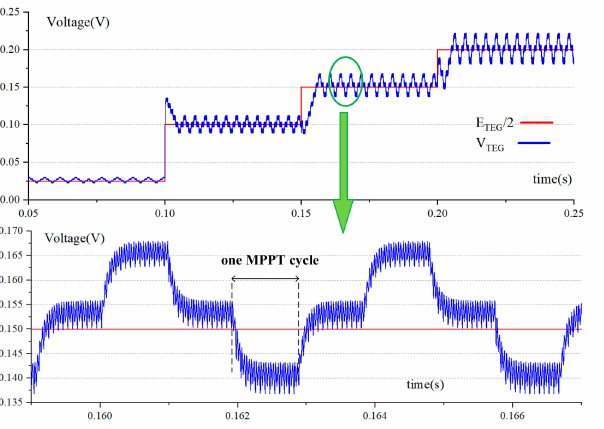
Figure 11. The waveform of V TEG , when E TEG changes from 50 mV to 400 mV and R TEG is 6 Ω . The input power of the DC–DC converter was obtained by the calculator module embedded in Spectre. The input power was divided by the ideal maximum power output of the TEG to obtain the tracking efficiency of the proposed MPPT circuit. The simulation result of the tracking efficiencies was between 98.9% and 99.5% for E TEG from 50 mV to 400 mV and R TEG from 1 Ω to 12 Ω , as shown in Figure 12, indicating that the MPPT circuit maintained extremely high tracking efficiency in a wide TEG